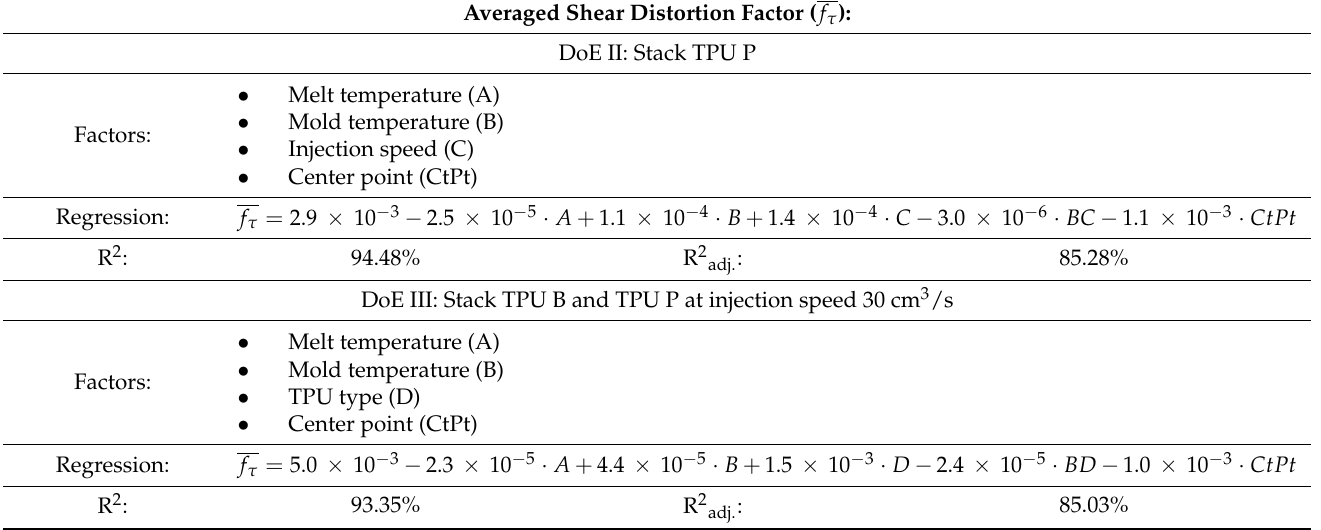
Table 7. Cont. Averaged Shear Distortion Factor ( f τ